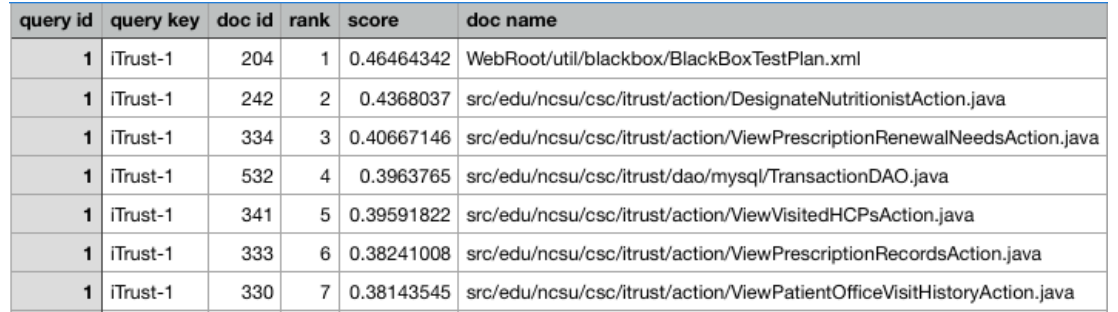
Figure 6: First 7 results in the ranked list of artifacts generated for iTrust after applying LSI